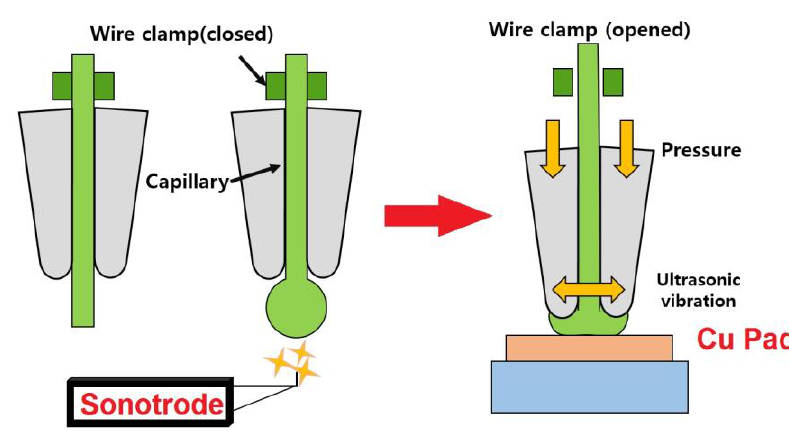
Figure 8. Schematic of the wire bonding process.